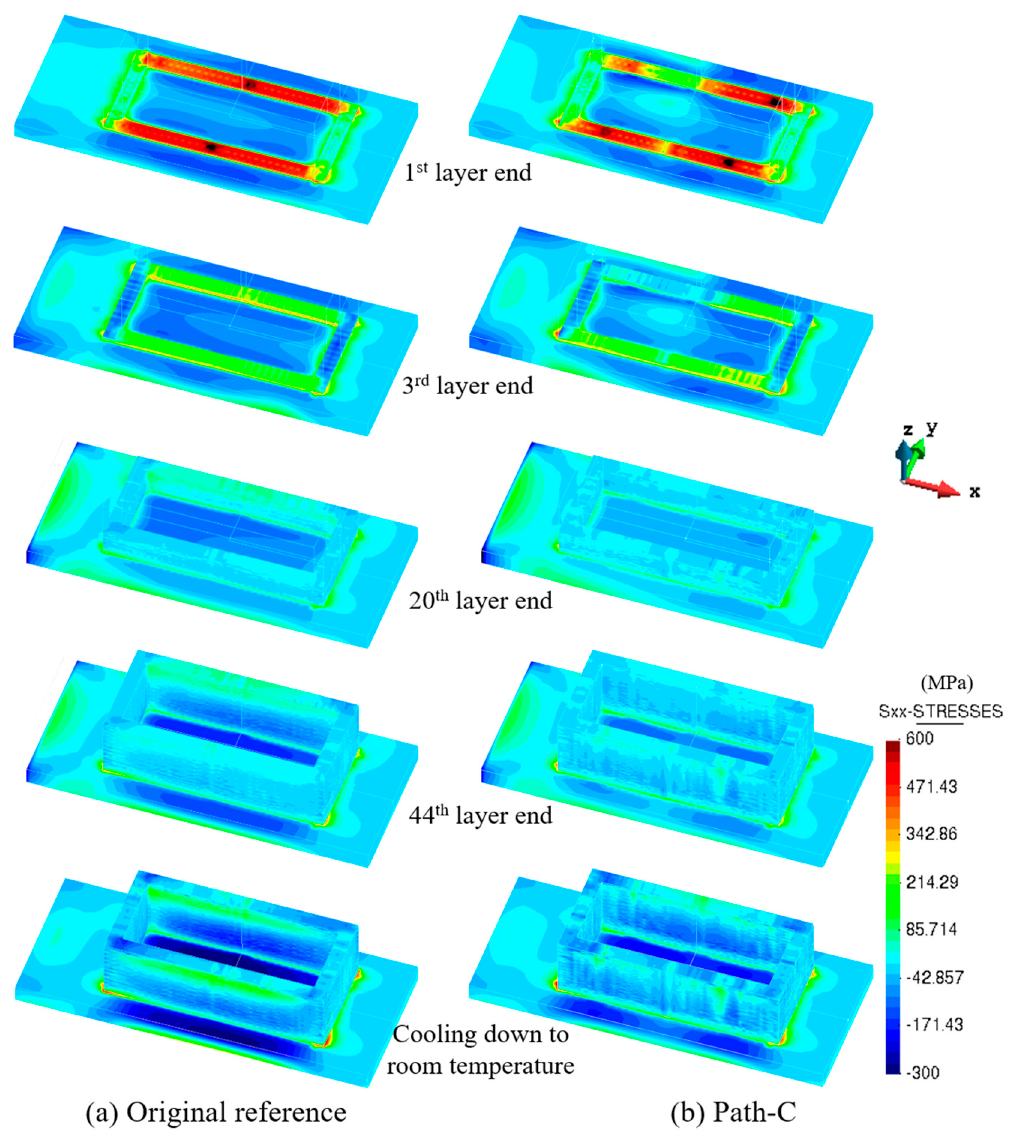
Figure 14. Rectangular part: the evolution of the longitudinal stress ( σ xx ) field under Case 1 for different building times.